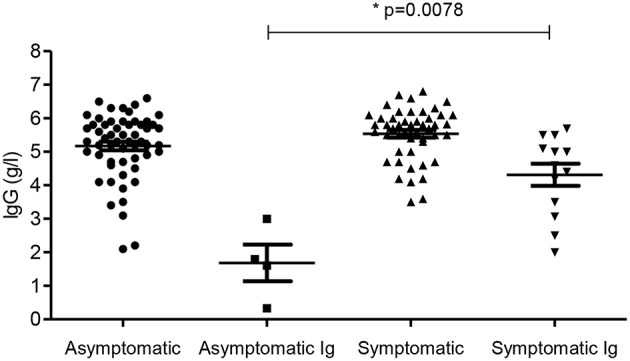
IgG levels in the four groups. Subgroups accepted for SCIG/IVIG are also shown. Ig- patients accepted for SCIG/IVIG. *The asymptomatic Ig group was compared to the symptomatic Ig group by the Mann–Whitney U-test.